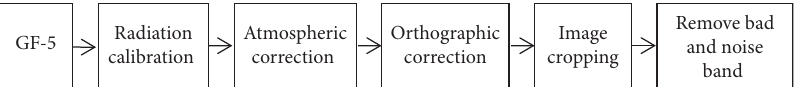
Figure 2: GF-5 data preprocessing flowchart.